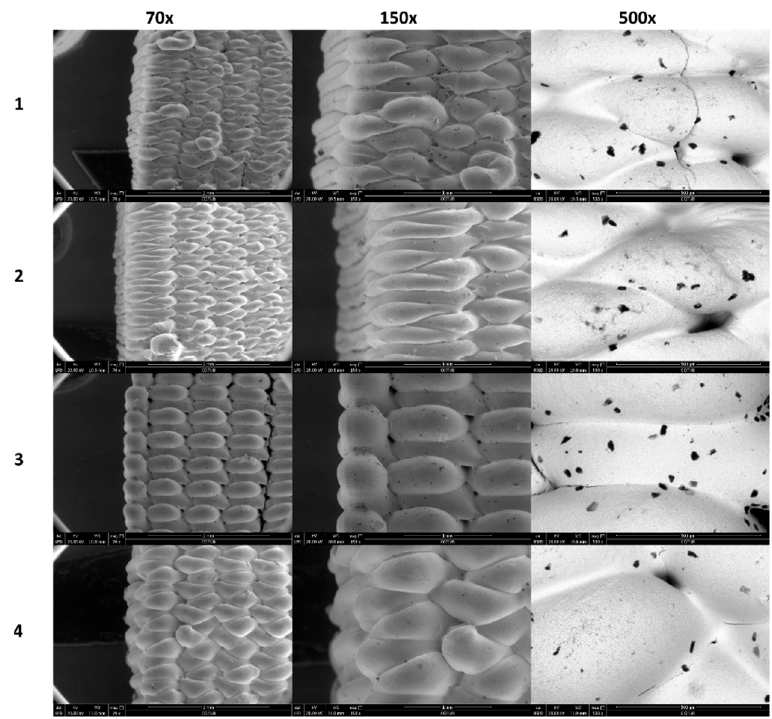
Figure 6. SEM images of the lateral wall of the cuboid of direction change of printed lines. SE images are 70X and 150X, and BSE images are 500X. Numbers 1, 2, 3, and 4 correspond to the different experiments defined in Table 1.